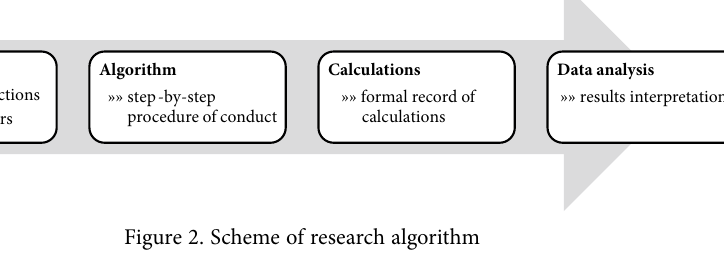
Figure 2. Scheme of research